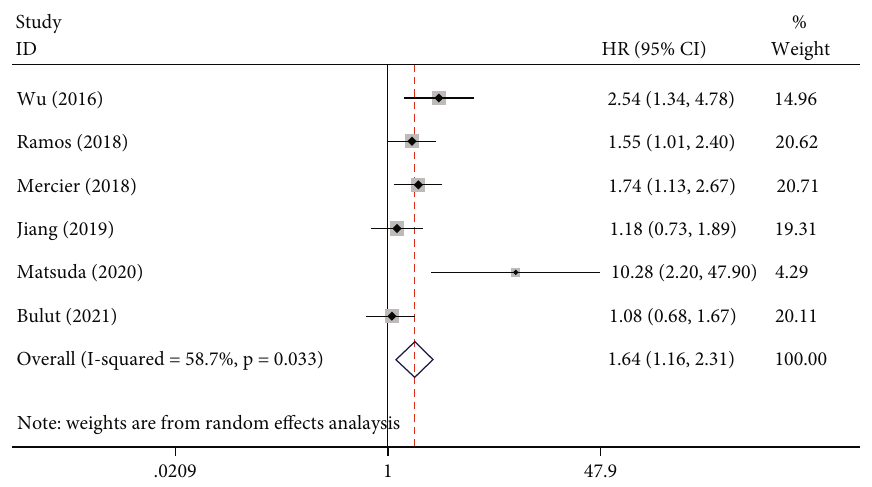
Figure 3: Results of prognostic analysis for PLR in mCRC for PFS.